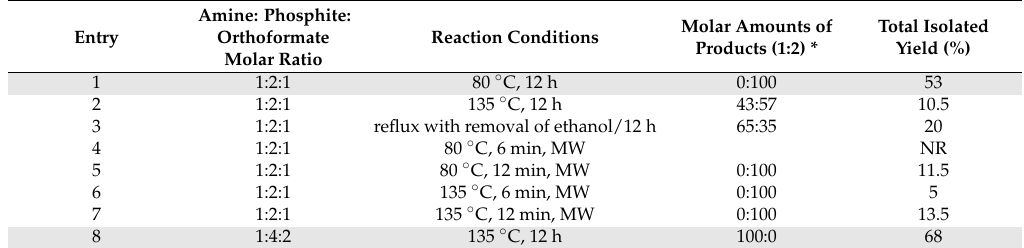
Table 1. Products of the reactions between benzylamine, triethyl orthoformate and diethyl phosphite. Entry